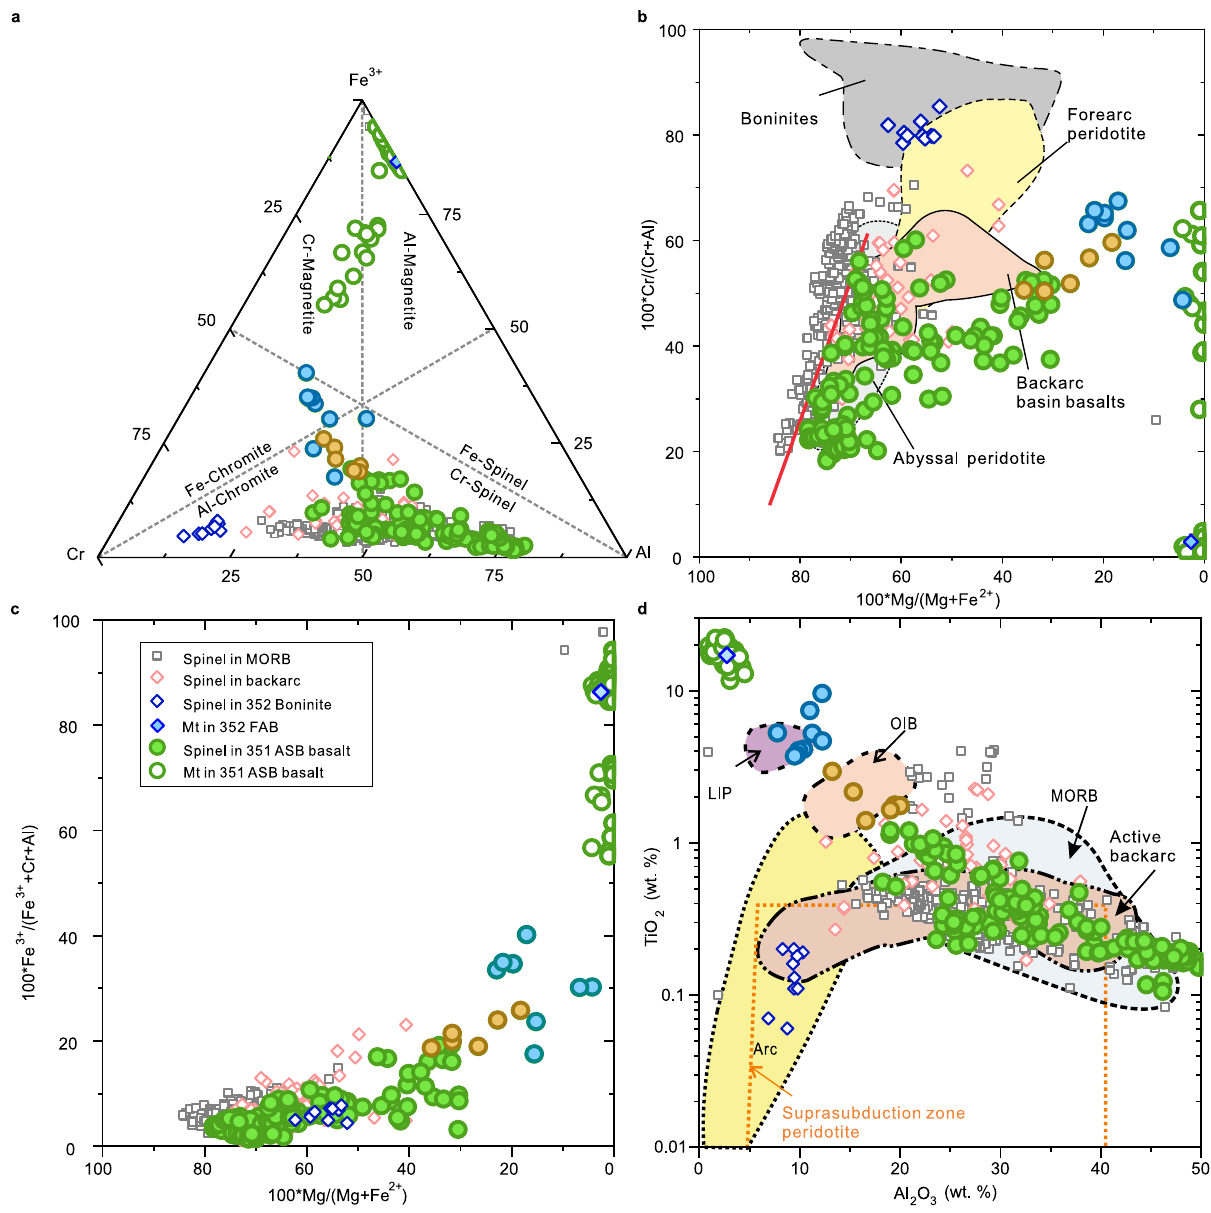
Fig. 4 Spinel compositions in 351 Unit 1 ASB basalt compared with mid-ocean ridge basalts (MORB) 38,40 , 352 boninite 36 , backarc (data from PetDatabase website). a Cr-Al-Fe 3 + cation diagram, dash lines are based on Stevens 66 . b 100 ∗ Cr/(Cr + Al) versus 100 ∗ Mg/(Mg + Fe 2 + ). c 100 ∗ Fe 3 + / (Fe 3 + + Cr + Al)) versus 100 ∗ Mg/(Mg + Fe 2 + ). d TiO 2 (wt. %) versus Al 2 O 3 (wt.%). Green solid circles are spinel in Unit 1 and grey solid square symbols are spinel in MORB. Red line in ( b ) delimits the highest Mg/(Mg + Fe 2 + ) for a given Cr/(Cr + Al) of the abyssal harzburgite array 41 . Coloured fi elds in ( b ) and ( d ) are based on Kamenetsky et al. (2001) 39 . To emphasise the compositional array, spinel compositions from Unit 1 that overlap the OIB (ocean island basalt) fi eld are depicted with brown circles while those overlapping the LIP (large igneous province) fi eld are shown with blue circles. The single published spinel (magnetite) analysis is from IBM FAB 36